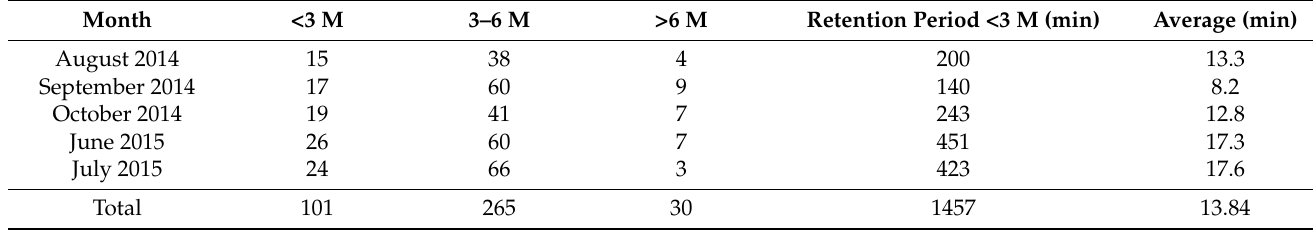
Table A2. Sušac island—density, distance and retention period of cruise ships’ traffic in selected high-risk navigational and environmental